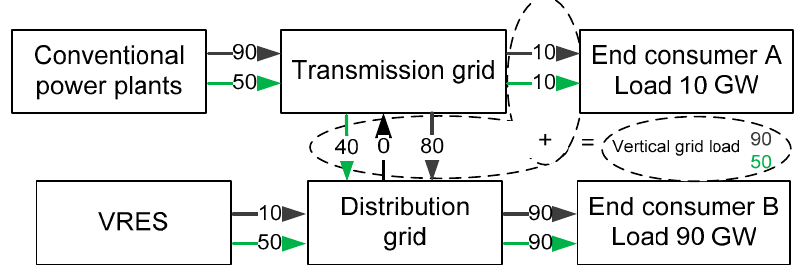
Figure 2. Power flow in GW: low share of VRES (black); high share of VRES (green) [28] (pp. 69–72).